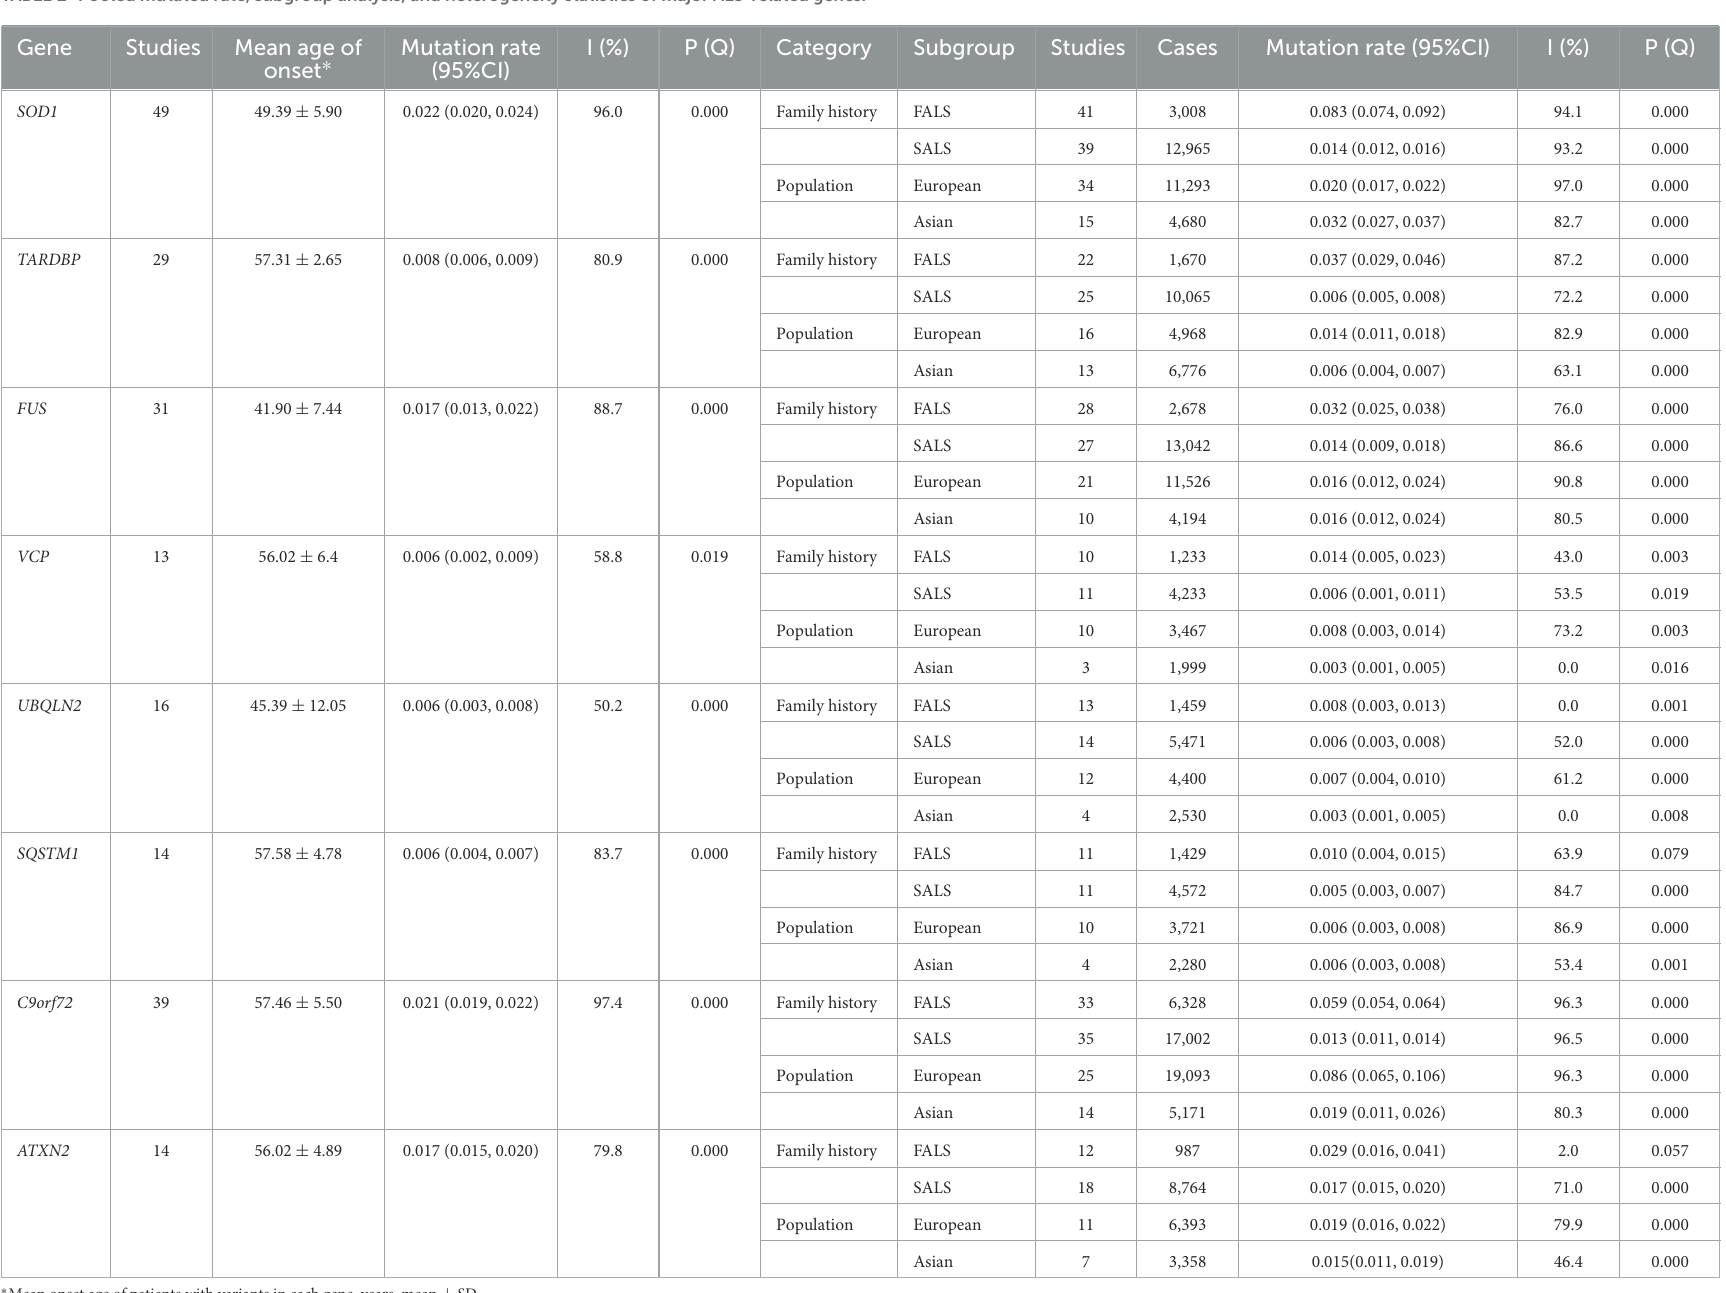
TABLE 2 Pooled mutated rate, subgroup analysis, and heterogeneity statistics of major ALS-related